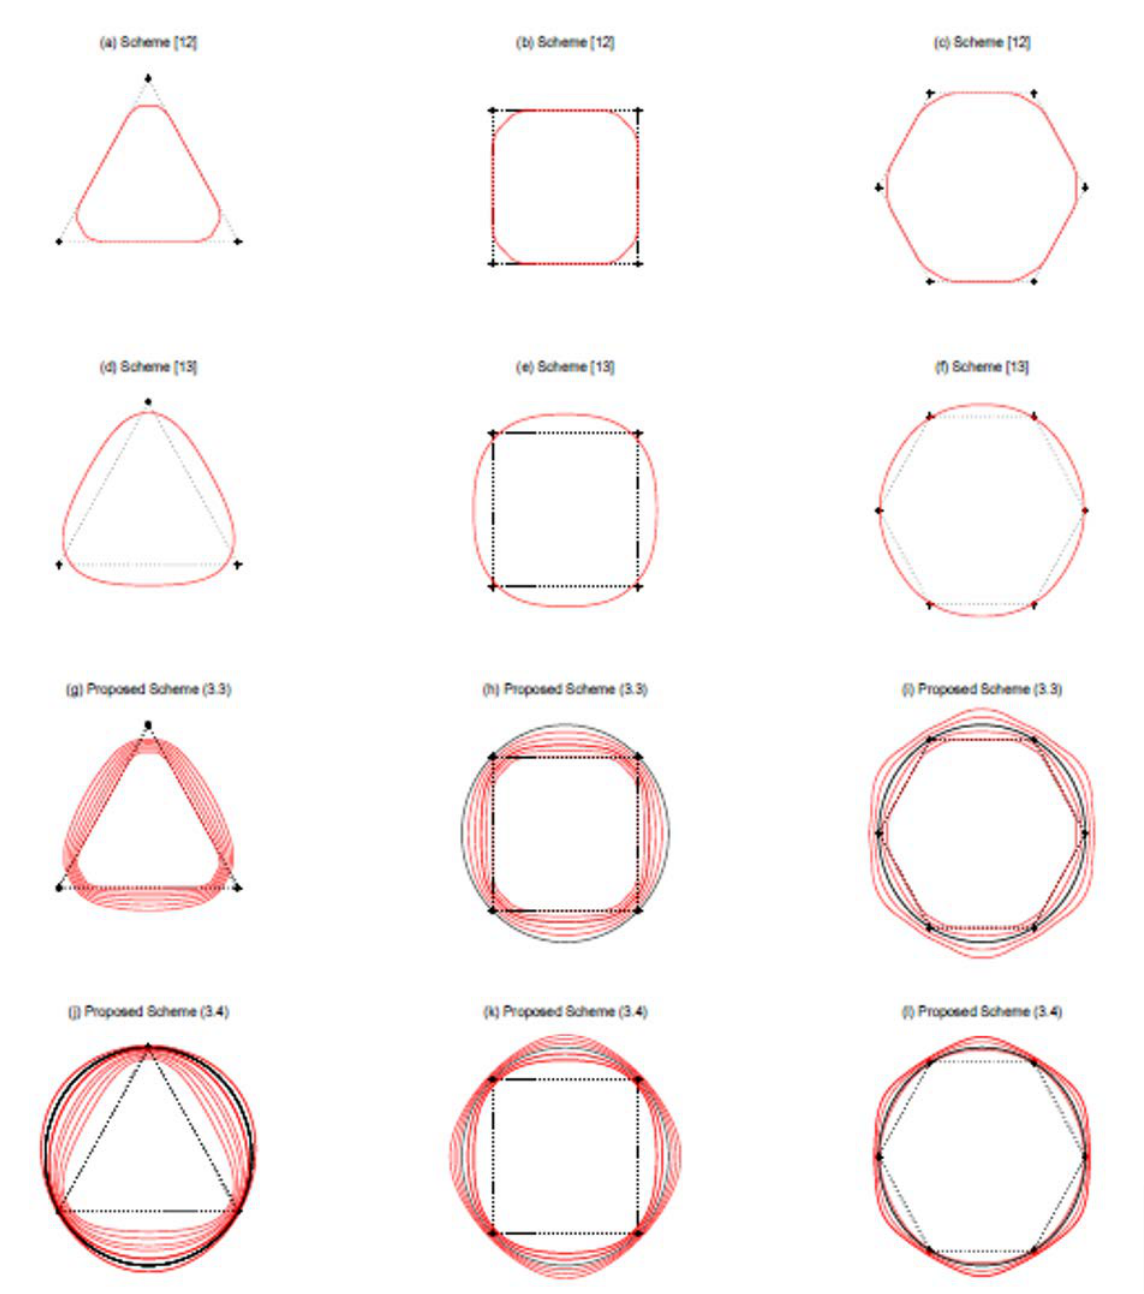
Figure 4. The different behaviour of the schemes [12], [13], proposed (8) and (11) in (a)-(c), (d)-(f), (g)-(i) and (j)-(l), respectively, after three subdivision steps.